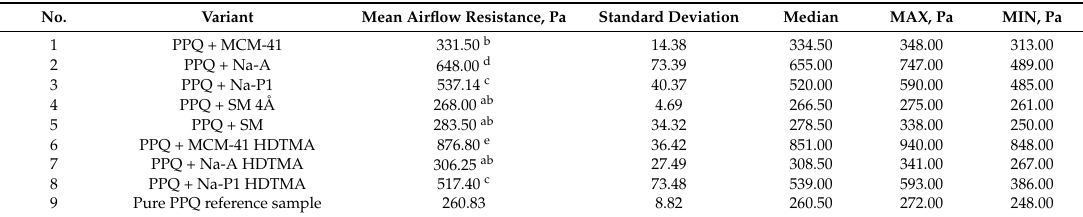
Table 6. Mean airflow resistance values for nonwoven composites containing zeolite and silica materials (descriptive statistics).